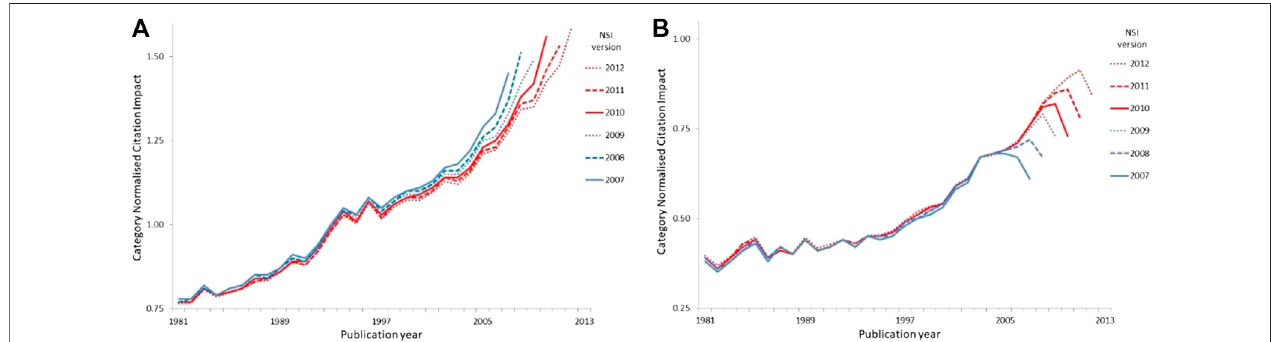
Figure 7 | (A) , (B) Average annual CNCI for Germany and for China as captured in successive time series from National Science Indicators (NSI, using versions publishedannuallyfrom2007to2012)basedondatain WebofScience